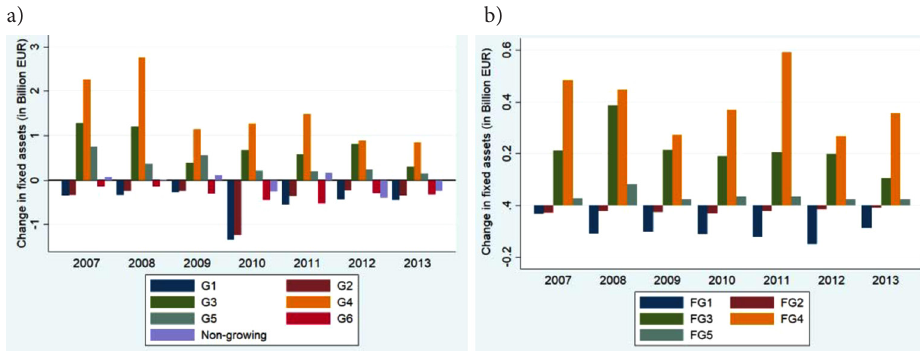
Figure 4. (a) Year-on-year change in the value of fixed assets by groups of growing firms (left); (b) year-on-year change in the value of fixed assets by fast growing